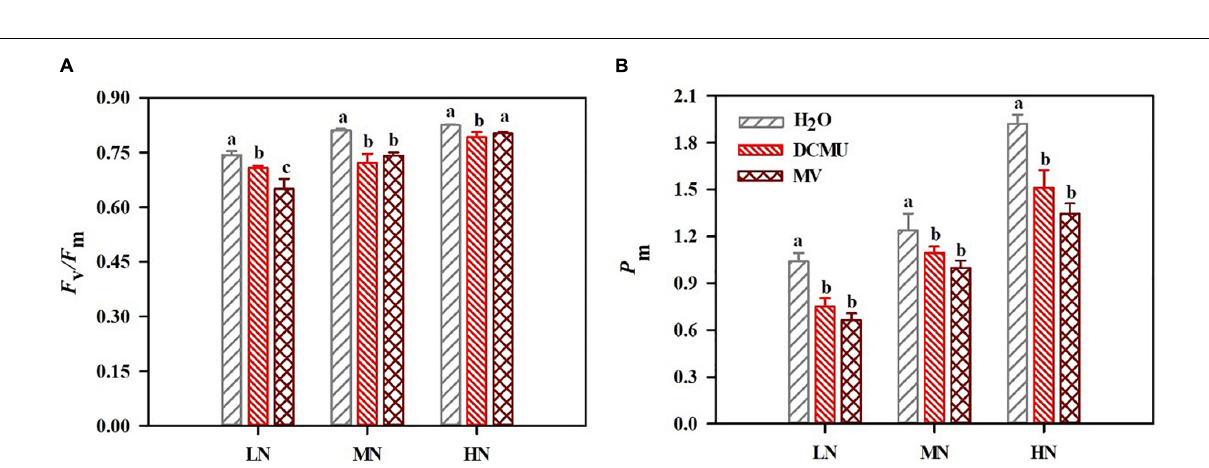
Frontiers in Plant Science |